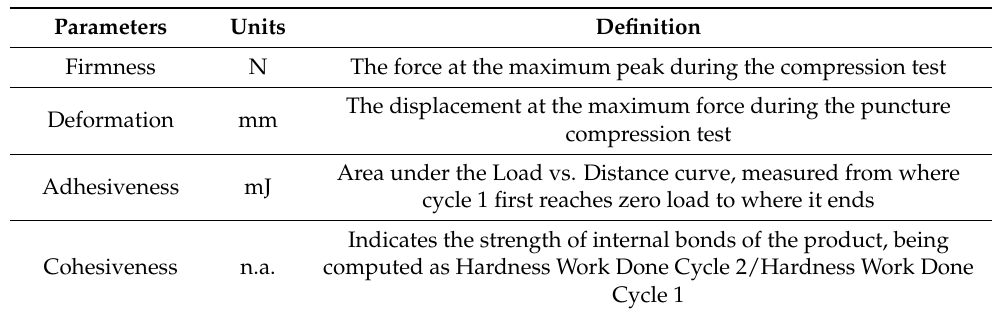
Table 2. Parameter definition and calculation for texture analysis.